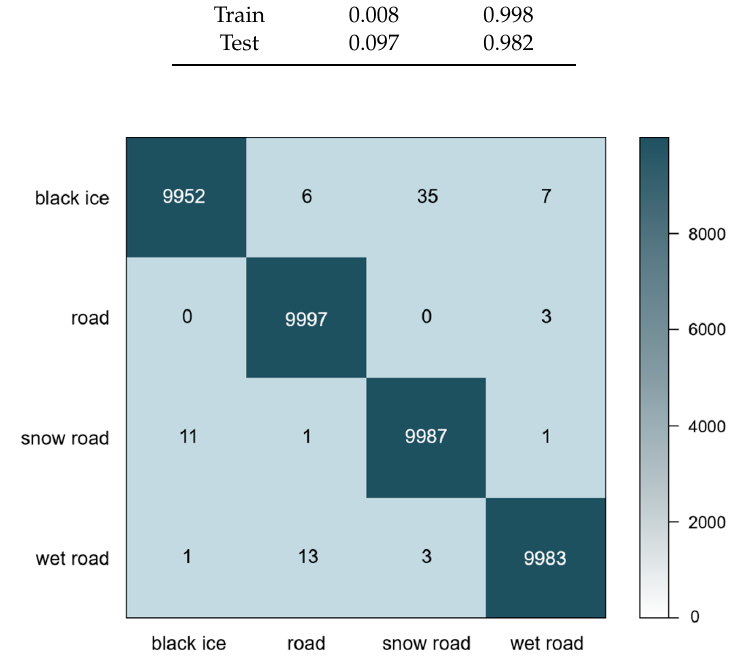
Figure 6. Confusion matrix; A matrix written to measure the prediction performance through training, the x -axis represents the predicted class and the y -axis represents the actual class. The results showed that (x,y) = (snow road, black ice) = 35, (black ice, snow road) = 11, (road, wet road) = 13. Secondly, the calculation and analysis of accuracy, precision, and recall of each class was conducted on test data. The calculation results of each performance indicator are shown in Table 10.